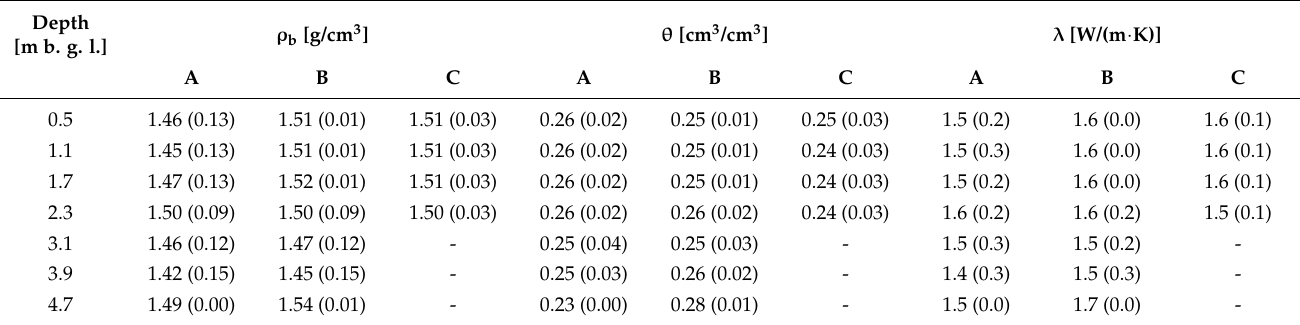
Table 9. Average derived values for ρ b , θ and λ for each section and for each measured layer of the ERTs. The standard deviation is also shown in the